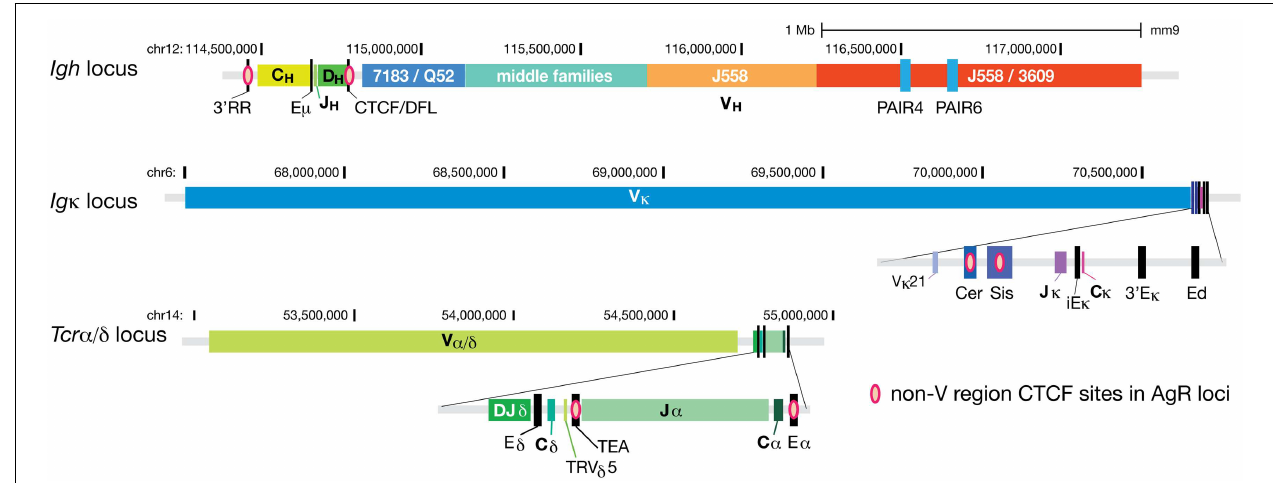
numerous CTCF sites scattered throughout the loci, hence too many to be represented.The two most prominent promoters of non-coding RNA transcribing regions of the Igh locus, PAIR4 and PAIR6, are also depicted as blue rectangles within the distal J558/3609